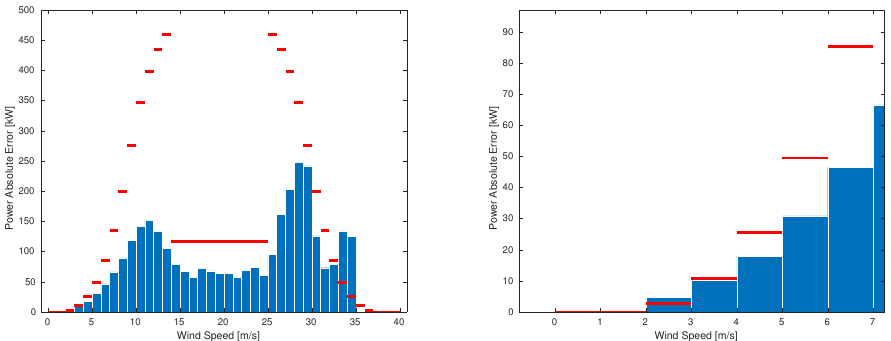
Figure 2. Histograms of the mean absolute error (MAE) of measured power. On the X-axes, we have a range of wind speed; each interval is 1m/s wide. The red lines represents the band